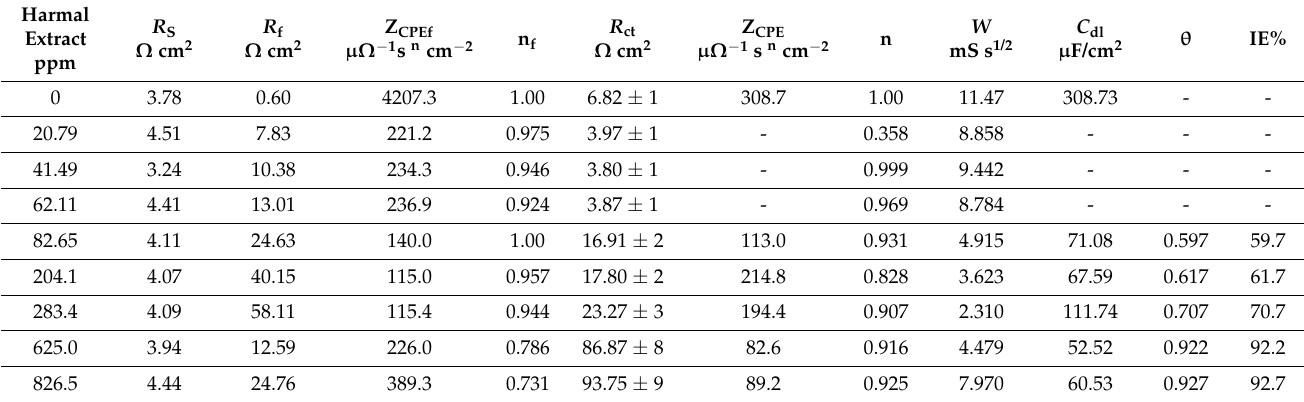
The decrease in C dl can result from a decrease in local dielectric constant and/or an increase in the thickness of the electrical double layer, suggesting that inhibition by molecules can be assisted by their adsorption at the metal/solution interface due to increase in surface coverage ( θ ) [6,61]. The highest protection capacity values 98% occurred with 283.4 ppm the optimum concentration of added Harmal extract, Table 2. Bode and Bode phase plots: log (imaginary part of impedance) (log |Z| (ohm)), and phase angle ( ◦ ) were plotted against log frequency (log f (Hz)), Figure 8a,b respectively, for C-steel in 0.25 M H 2 SO 4 in the absence and presence of Harmal extract. The α value indicates the alloy surface irregularity. It is calculated from the slope of the linear region of log(f) versus log|Z| plots (Figure 8a). The α values for C-steel in 0.25 M H 2 SO 4 (with and without Harmal extract) were calculated. Ideally, the value of α should be equal to − 1 for an ideal capacitor. Coarseness and heterogeneity of the C-steel surface was attained for less than − 1 values. It can be seen that the presence of Harmal extract increased the α value to more negative values from − 0.256, − 0.279, − 0.366, ranging from 0, 20.79, 41.49, 62.11, 82.65, 204.1, 283.4, 625.0, to 826.5 ppm. The decrease of heterogeneity of C-steel surface occurred as a result of adsorption of Harmal extract [61]. Figure 8b shows phase angle ( ◦ ) plotted against (log f (Hz)). It is clear that increasing Harmal extract causes more negative values of phase angle at the intermediate frequency; the phase angle values were − 24.15 ◦ (0 ppm), − 32.43 ◦ (62.11 ppm), − 44.44 ◦ (82.65 ppm), As the concentration of Harmal extract increases, the values of phase angle become more negative. This indicates that the inhibitive behavior occurred because more of the Harmal molecules adsorbed at the C-steel surface